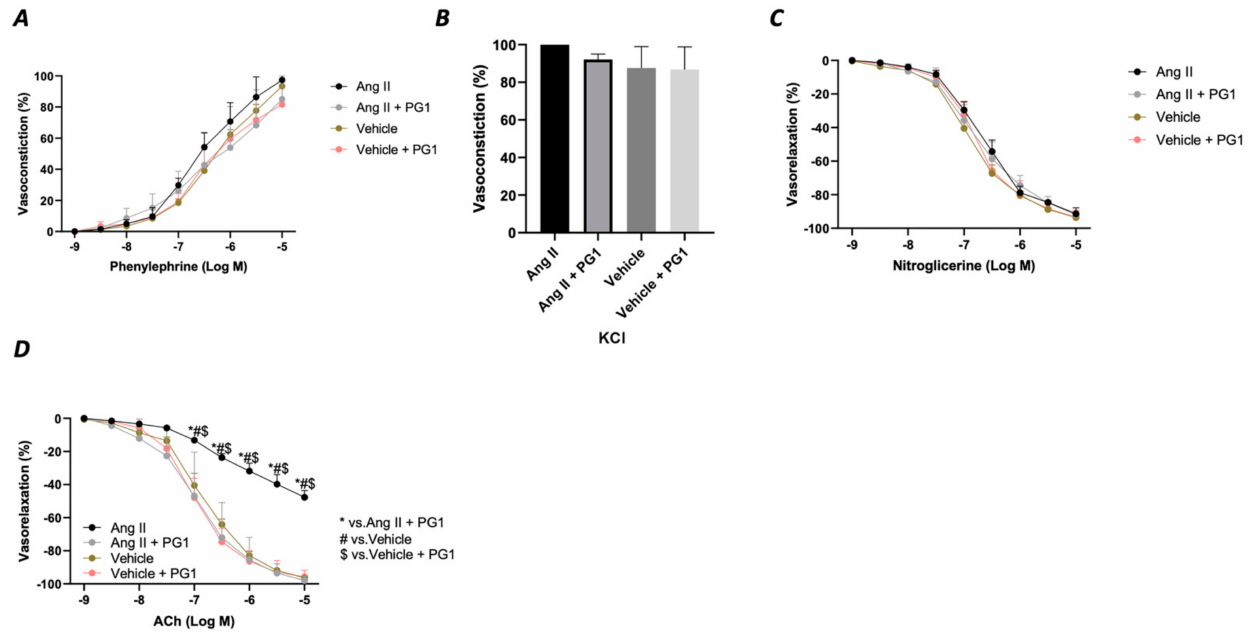
Figure 4. Assessment of vascular response of mice mesenteric arteries obtained at the end of in vivo (14th day) treatment from wild-type mice daily treated with gavage of vehicle or PG1 (10 mg/Kg), or in wild-type angiotensin (Ang) II-infused mice daily treated by gavage administration of vehicle or PG1 (10 mg/Kg) mice to ( A ) phenylephrine, ( B ) Potassium chloride, ( C ) Nitroglycerine ( D ) acetylcholine.